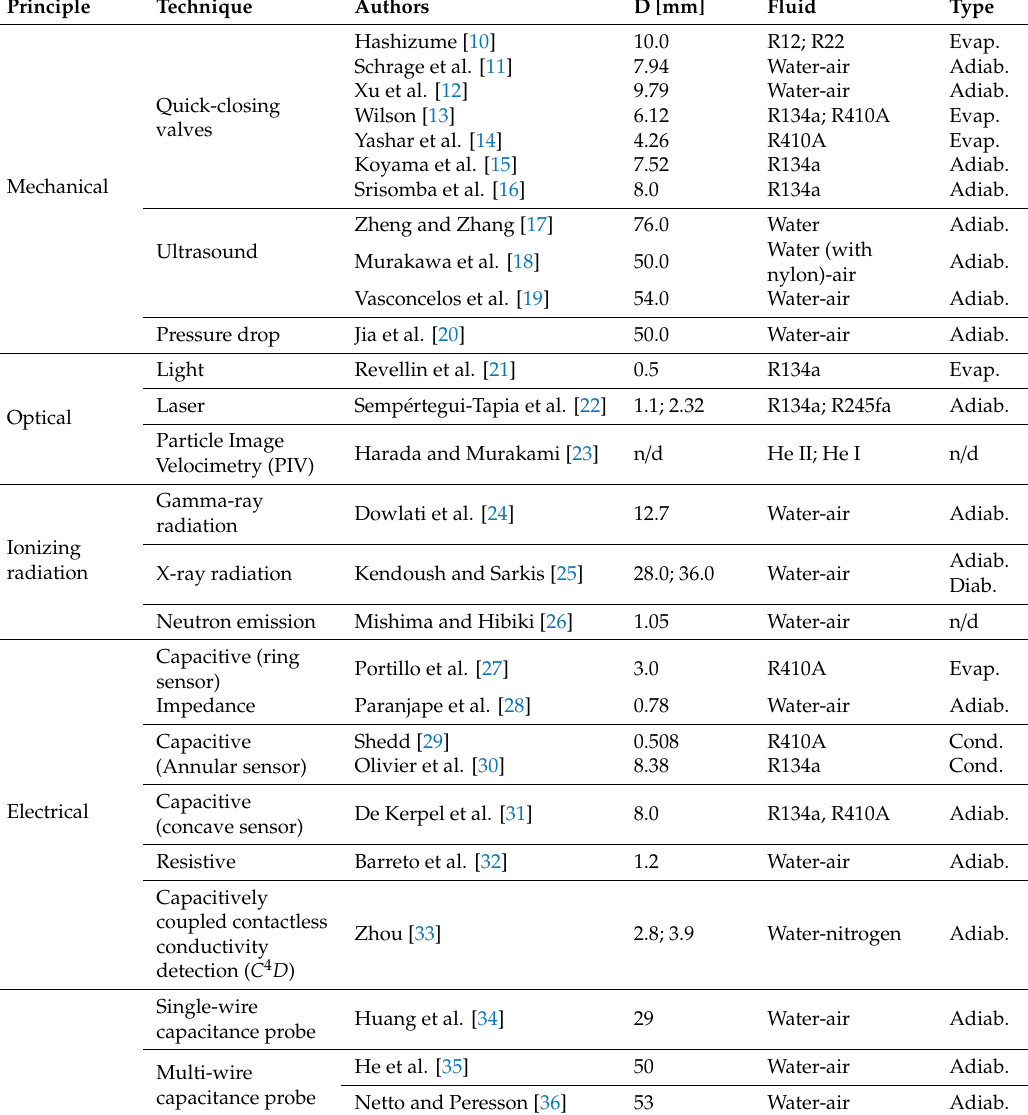
Table 1. Studies of two-phase flow using di ff erent methods of void fraction